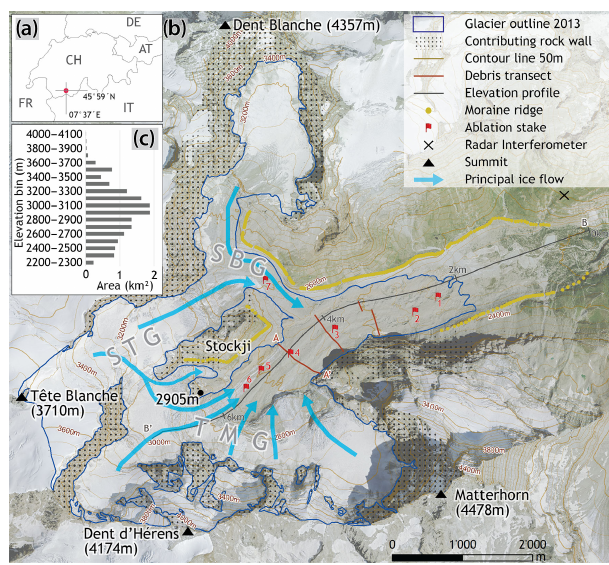
Figure 1. (a) Geographical location. (b) Zmuttgletscher, its topo- graphical setting and different tributaries: SBG: Schönbielgletscher; STG: Stockjigletscher; TMG: Tiefmattengletscher. Background im- age: orthomosaic from aerial imagery by Swisstopo from 2013 (Swisstopo, 2010). (c) Glacier hypsography in the year 2010 (©